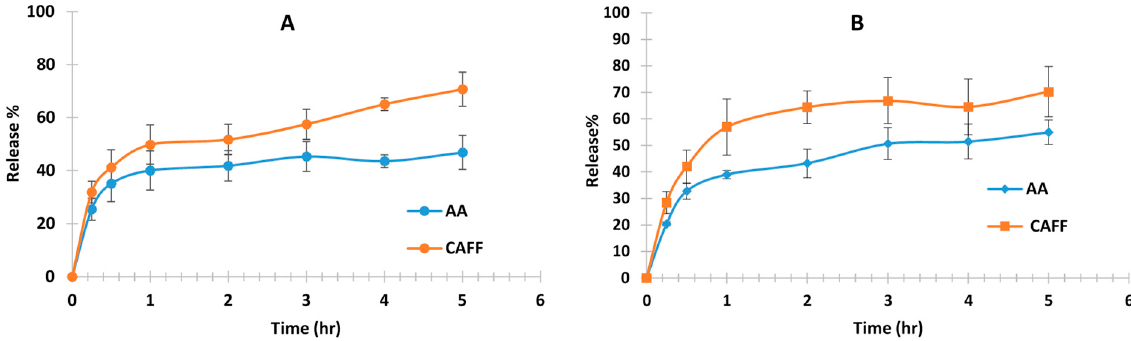
Figure 5. In vitro release studies of AA and CAFF from ( A ) S4 and ( B ) S7 niosome (n = 4).